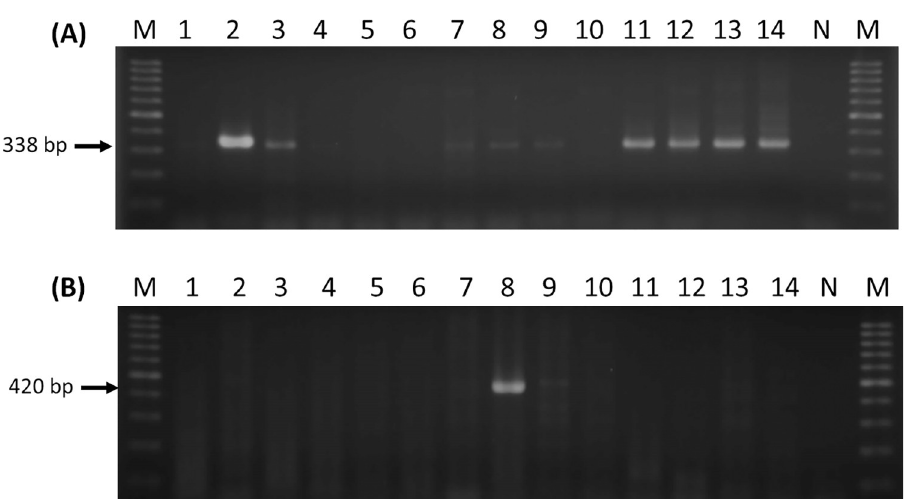
Fig 2. Molecular detection of Rickettsia infection in Rhipicephalus sanguineus ticks from Tainan City of Taiwan by nested PCR assay targeting (A) citrate synthase ( gltA ) and (B) outer membrane protein B ( ompB ) genes. M, 100 bp DNA marker; 1–14, sample number; N, negative control. The expected PCR product of 338 bp and 420 bp for gltA and ompB , respectively. https://doi.org/10.1371/journal.pntd.0010917.g002 < 0.059 for R . massiliae and R . felis ) of genetic divergence within the Rickettsia strains of Tai- wan, as compared with the type strain of R . massiliae and R . felis , respectively (Table 3). Fur- ther analysis based on the GD values of ompB gene indicated a lower levels (GD < 0.013 and < 0.052 for R . massiliae and R . felis ) of genetic divergence within the Rickettsia strains of Tai- wan, as compared with the type strain of R . massiliae and R . felis , respectively ( Table 3 ). Nucleotide sequence accession numbers The nucleotide sequences of PCR-amplified gltA gene of 9 Rickettsia strains from Rh . sangui- neus ticks of Taiwan determined in this study have been registered and assigned the following